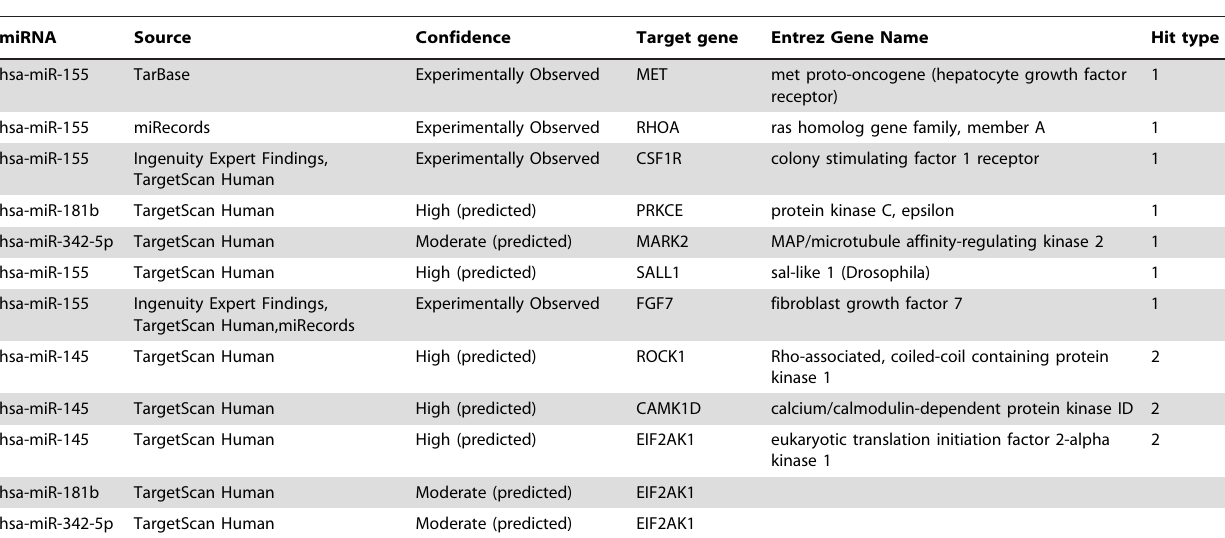
Table 3. Predicted miRNA target genes with proliferation-decreasing or apoptosis-inducing phenotype in siRNA screenings of the glioma cell lines.